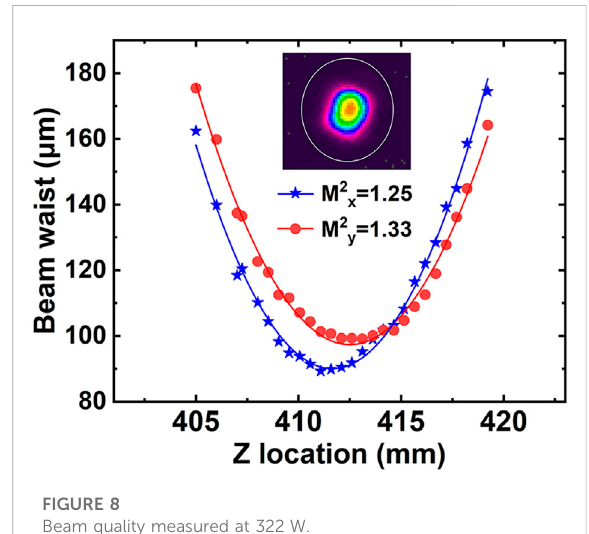
FIGURE 8 Beam quality measured at 322 W.